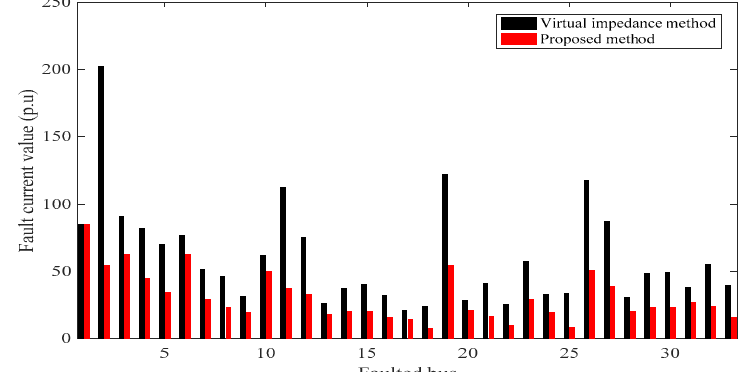
Figure 7. The value of fault current in all buses using two approaches.